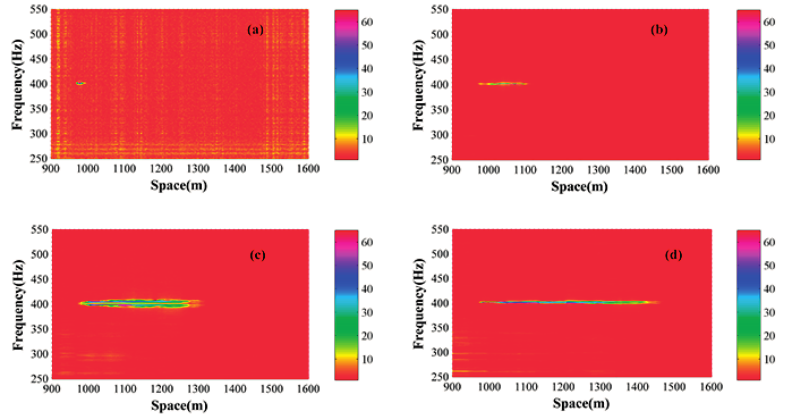
Figure 6. Frequency and space relationship under different pulse widths. ( a ) 200 ns pulse width; ( b ) 1500 ns pulse width; ( c ) 3500 ns pulse width; ( d ) 5000 ns pulse